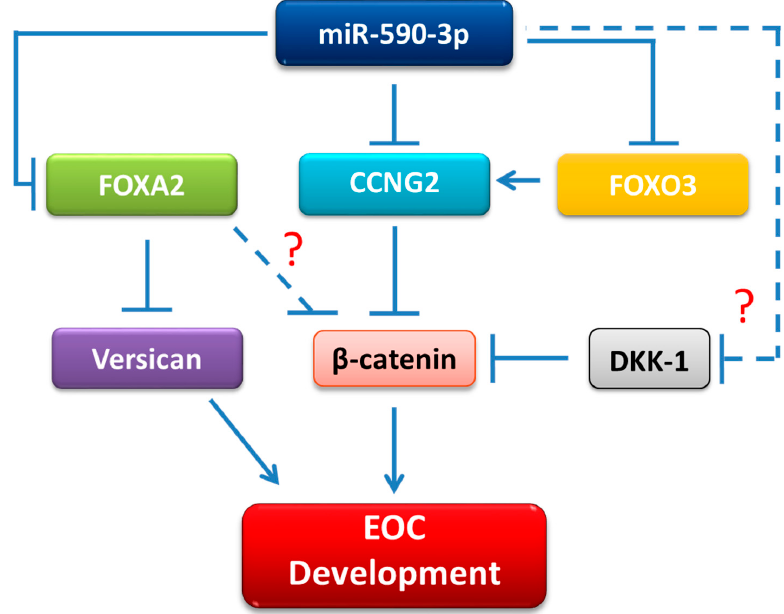
Figure 7. The proposed mechanism of mir-590 in promoting EOC development. miR-590-3p targeted the CCNG2 , FOXO3 , FOXA2, and, probably, DKK1 , leading to an increase in the β -catenin